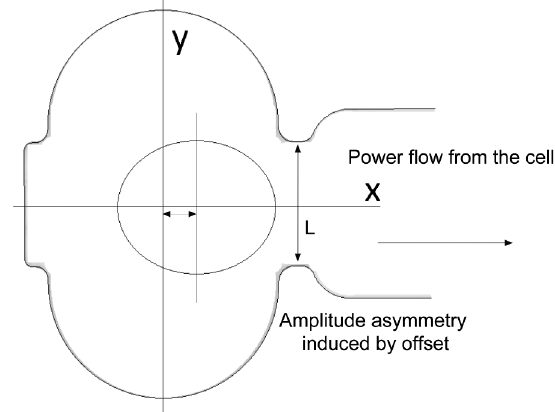
FIG. 8. The TM 010 -like mode longitudinal electrical field amplitude asymmetry due to the on-cell damper coupling. The coupling is tuned by the on-cell opening length L